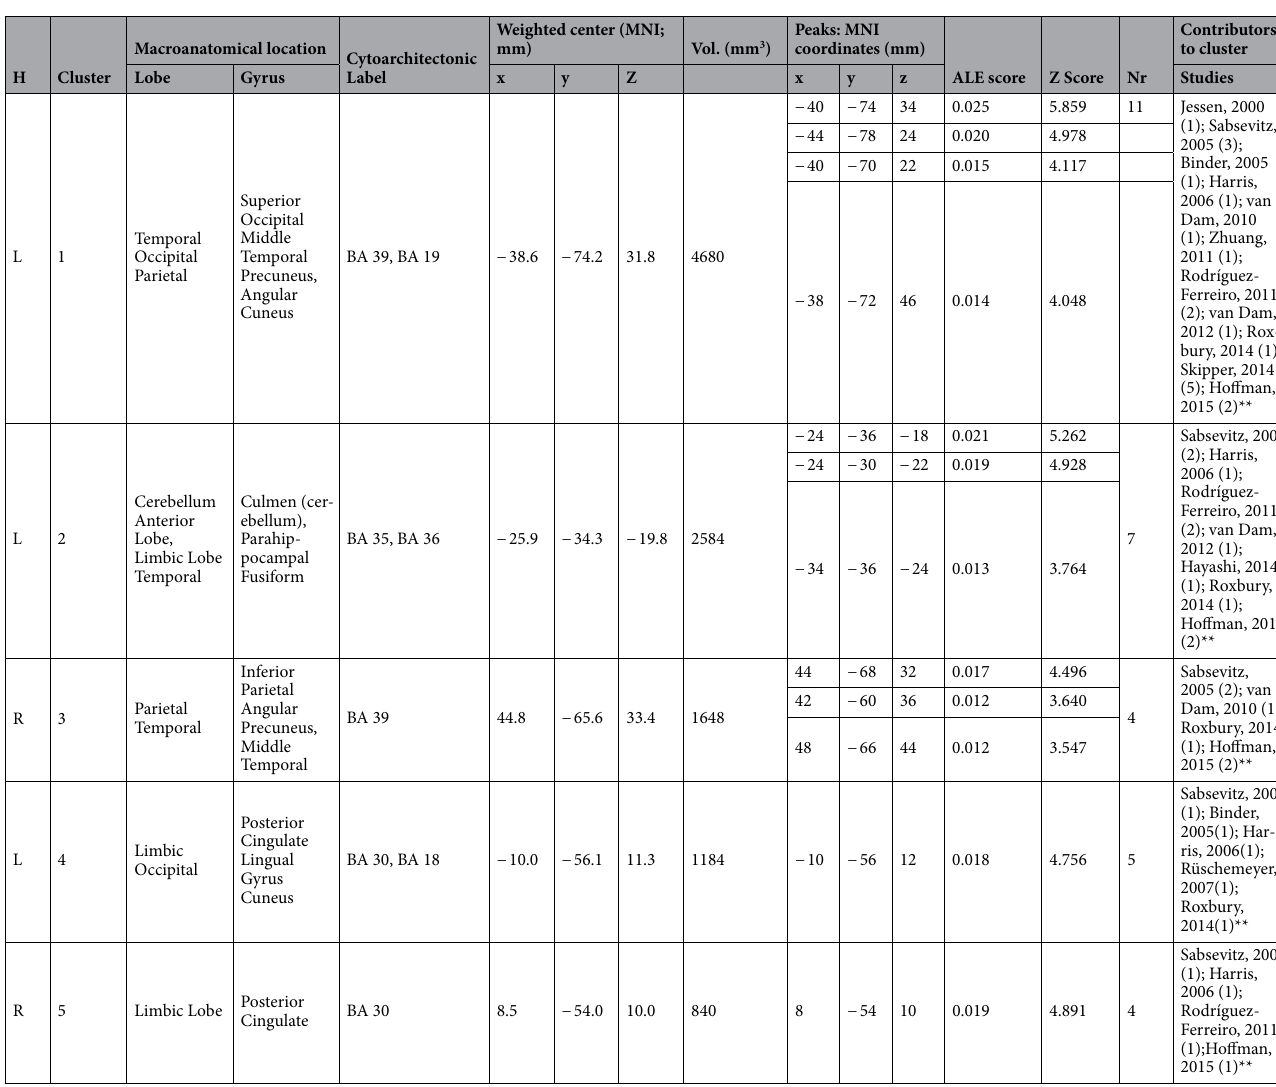
Table 2. Concrete > abstract word clusters. Included 149 stereotactic activation loci from 22 studies, 353 participants, Chosen min. cluster size 736 mm 3 . All the values and labels were extracted from the GingerALE output files. Clusters are ordered for decreasing volume size. Coordinates (x, y, z) are in the MNI space. H = Hemisphere; ALE = activation likelihood estimation; Nr. = number of studies that contributed to each cluster; L = left; BA = Brodmann area; ** = between brackets are the number of foci from each study that contributed to that specific cluster; R =